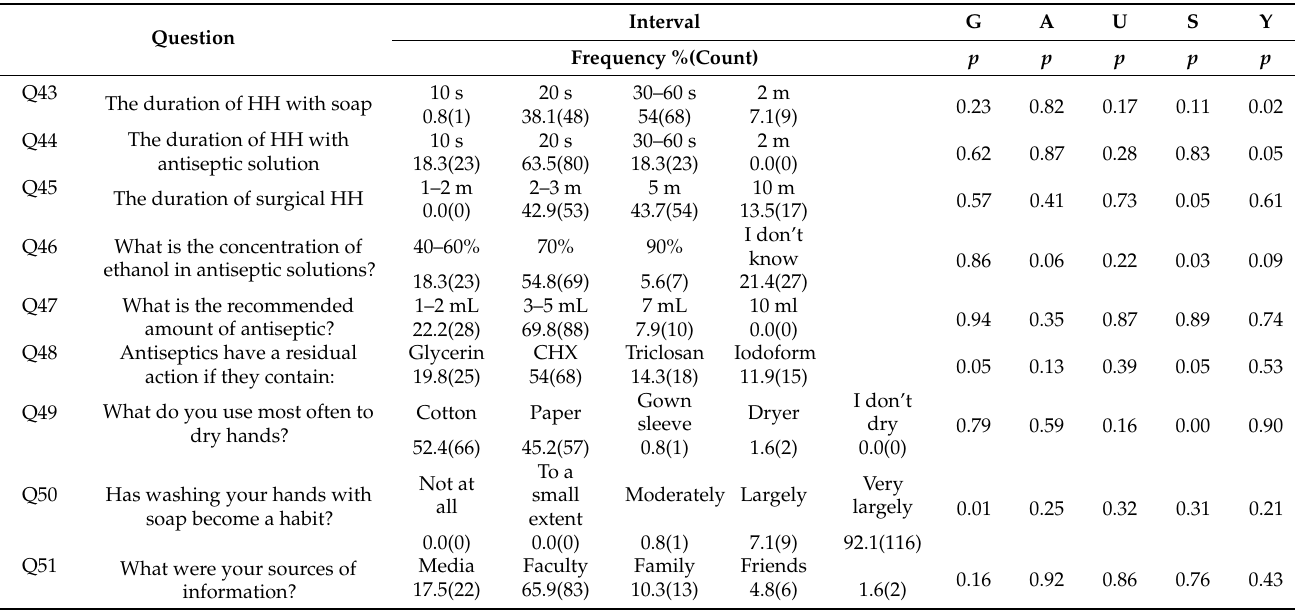
Table 5. Frequency of answers to questions concerning antiseptic substances for HH. Results of statistical significance tests comparing the frequency of answers on antiseptic substances for HH, by